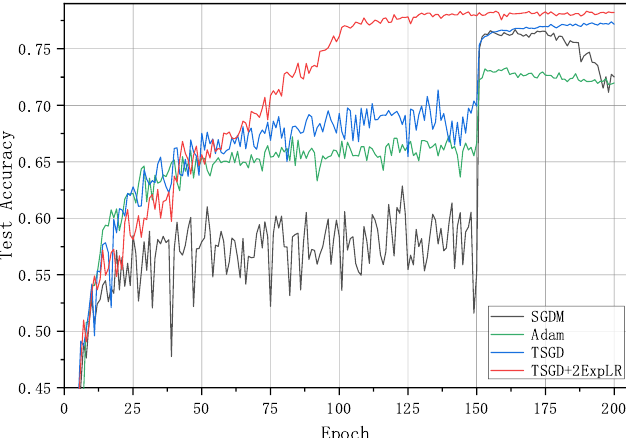
Figure 10. The accuracy of Cifar100-ResNet18 on the test set.